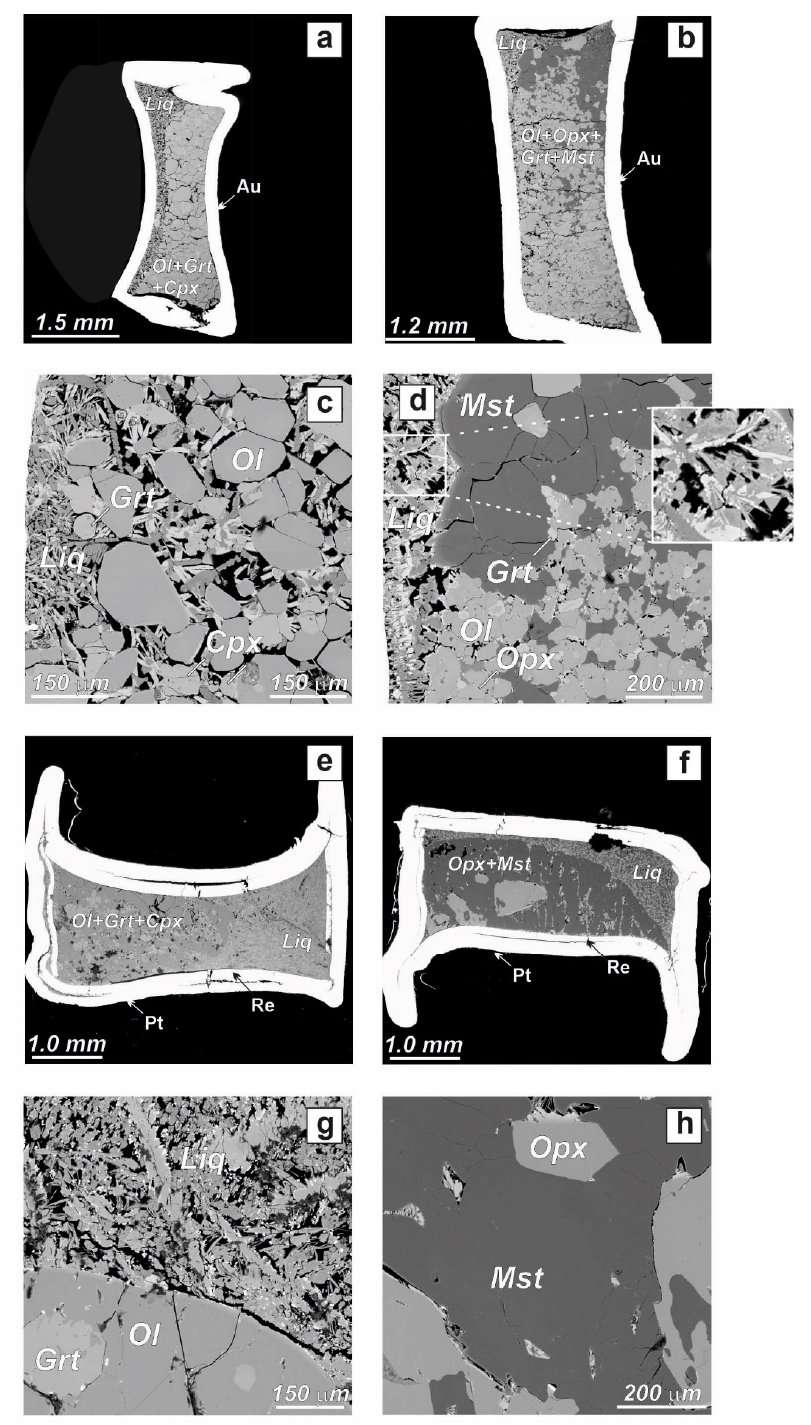
Figure 1. Backscatter electron images of representative run products in the lherzolite–carbonatite B10 (Lc-B10) system. ( a , c ): No. 2200_2_7 (T = 1200 °C; Lc-B10 with added H 2 O); ( b , d ): No. 2200_2_1 (T = 1200 °C; Lc-B10 with added CO 2 and H 2 O); ( e , g ): 2192_2_1 (T = 1350 °C; Lc-B10 with added H 2 O); ( f , h ): No. 2190_2_3 (T = 1350 °C; Lc-B10 with added CO 2 and H 2 O). Inset show microcavities between dendritic crystals. Abbreviations: Opx = orthopyroxene; Grt = garnet; Mgs = magnesite; Liq =